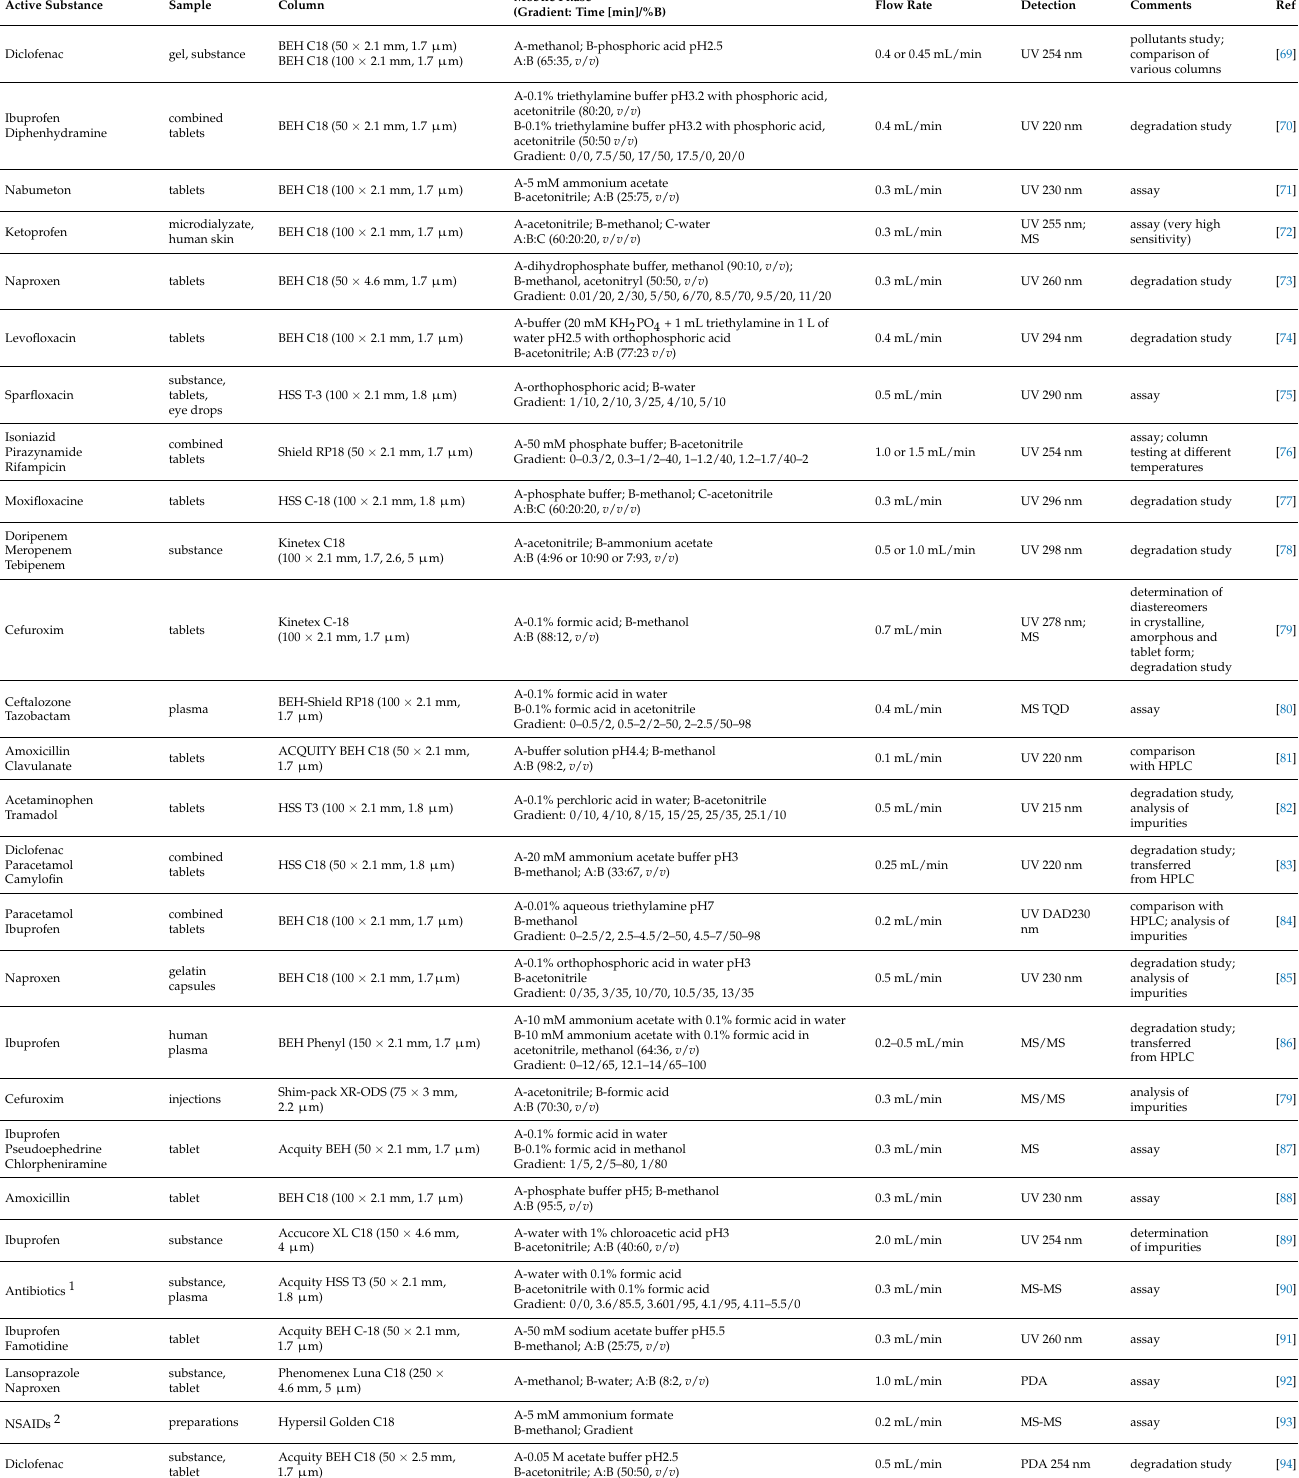
Table 2. UPLC technique in the analysis of NSAIDs and